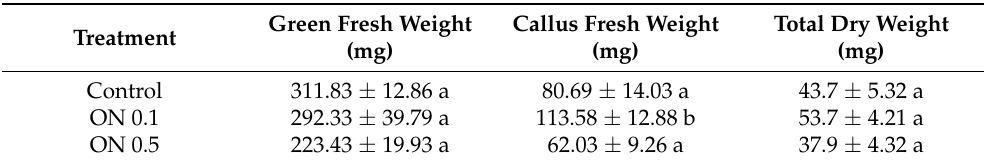
Table 1. Means of green fresh weight, callus fresh weight, and total dry weight of the proliferated explants obtained in the three subsequent